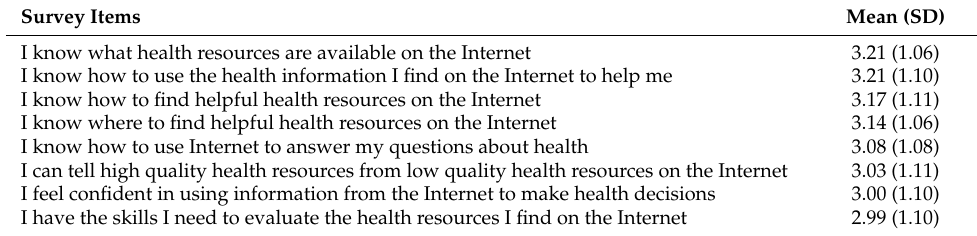
Figure 3. eHealth literacy scale scores compared by sociodemographic sub-groups. * Indicates p < 0.05, ** indicates <0.001. Figure 2. Ownership of technological devices among Chinese immigrants.